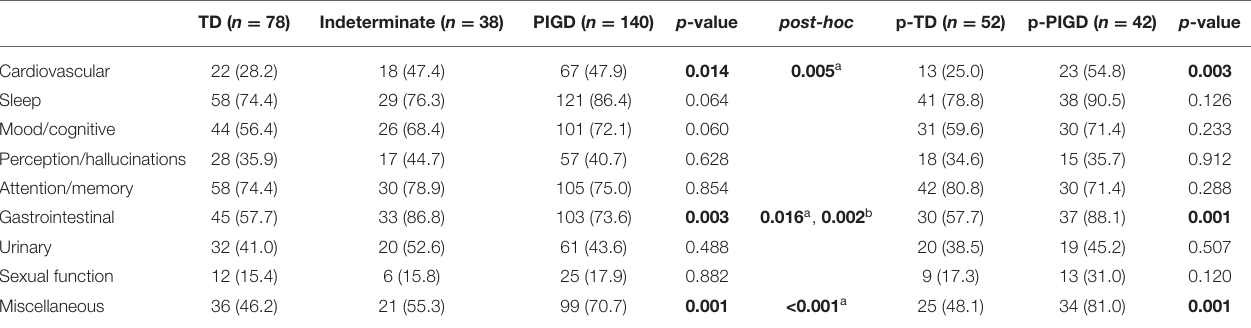
TABLE 5 | Comparison of the non-motor symptoms in two motor subtype classifications of de novo Parkinson’s disease